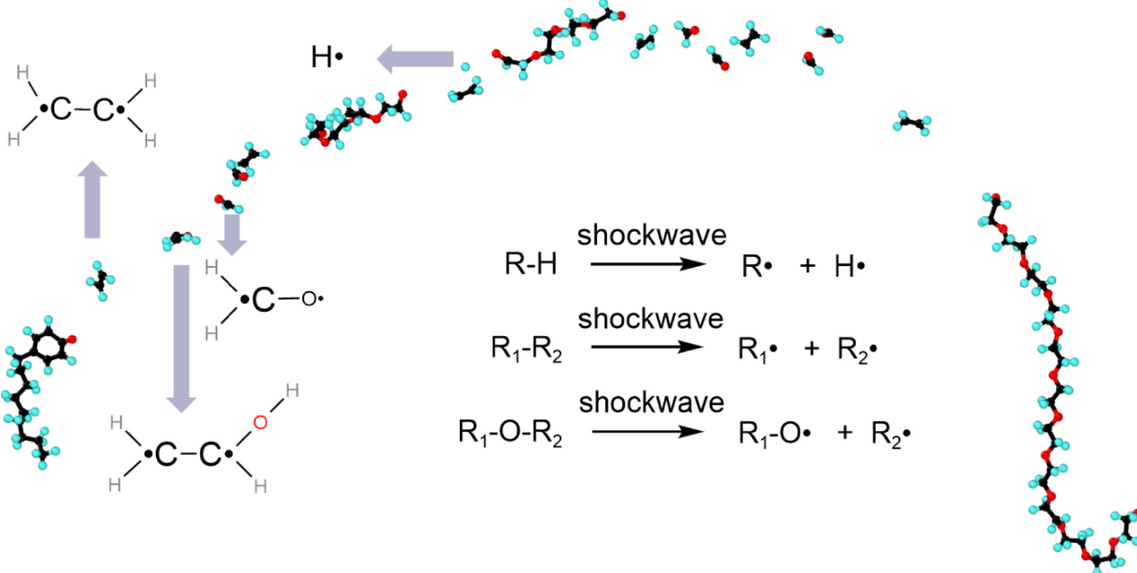
Figure 6. The rupture of NP30EOs after the collapse of the vacuum nanobubble and the generated radicals. In this figure, different reaction pathways for free radical generation are also given.